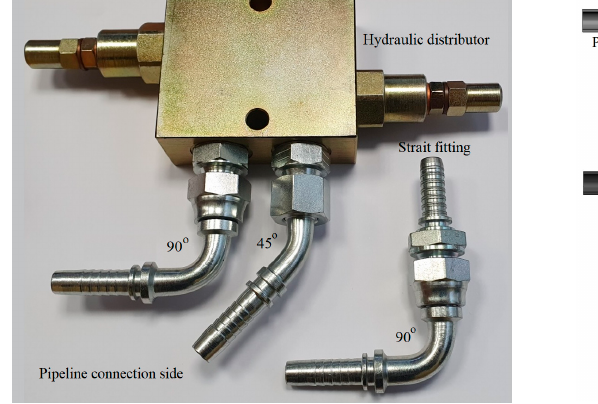
Figure 2. Fittings used in the research: ( a ) Connection of angular fittings in a hydraulic system; ( b ) Cross-section of angular fitting connections in 3D pipelines models.